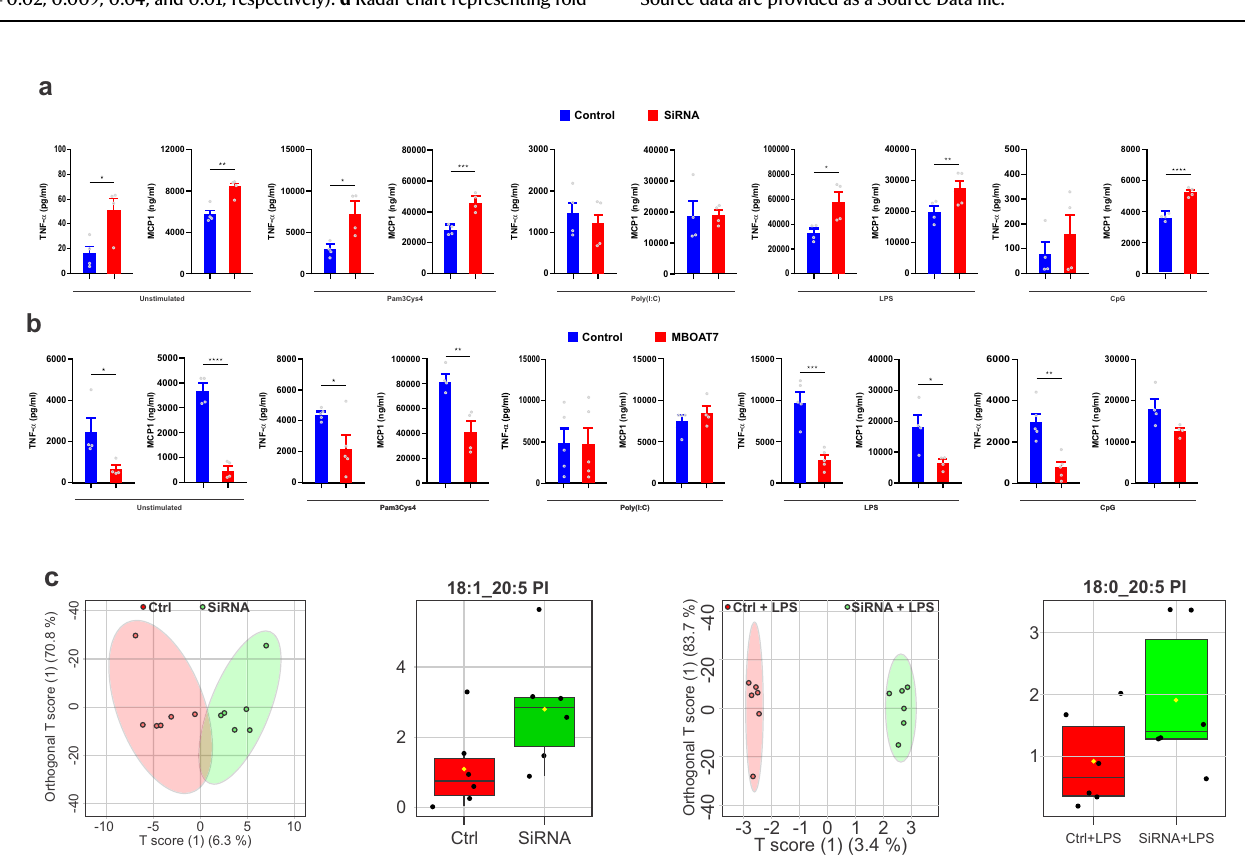
Fig. 1 | Human macrophages from rs8736 TT carriers demonstrate higher cytokine secretion upon TLR stimulation compared with C allele carriers. a Scheme illustrating the experimental design. MDMs ( n =10/genotype) were treatedfor24hwiththeindicatedTLRsligands(Pam3Cys4[TLR2],Poly(I:C)[TLR3], LPS[TLR4],andCpG[TLR9]).ShownisquantitativeELISAoftheconditionalmedia measuring b TNF- α ( P =0.04, 0.8, 0.02, and 0.9, respectively) and c MCP-1 ( P =0.02, 0.009, 0.04, and 0.01, respectively). d Radar chart representing fold